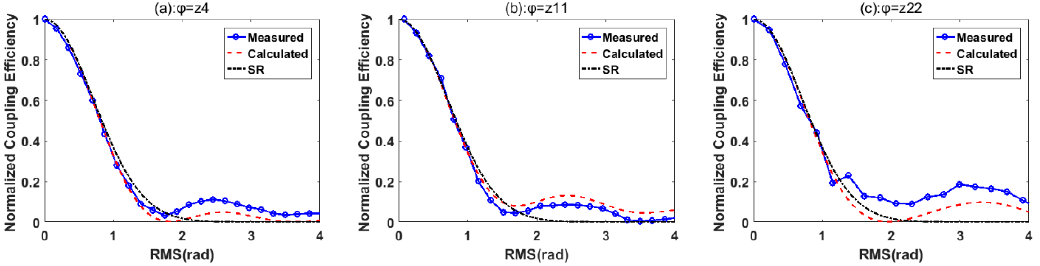
Figure 11. Relation between circularly symmetric aberrations and CE. ( a ) φ = Z4; ( b ) φ = Z11; ( c ) φ = Z22.